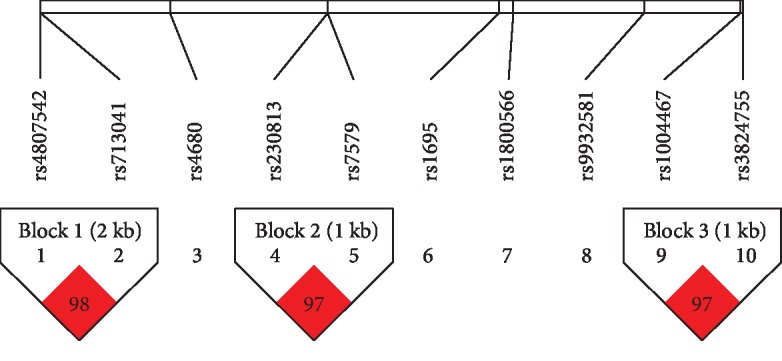
Oxidative stress-LD plot. We estimated the LD and haplotype using Haploview 4.2. Three SNPs had strong correlations; rs4807542 and rs713041(GPX4), rs230813 and rs75799 (SEPP1), and rs1004467 and rs3824755 (CYP17A1) were in high LD with each other and were selected as a block (r2 = 0.98, r2 = 0.97, r2 = 0.97, r2 > 0.9, t). rs713041 in GPX4 exhibited high LD (r2 = 0.98) with rs4807542, and both were significantly associated with PE.